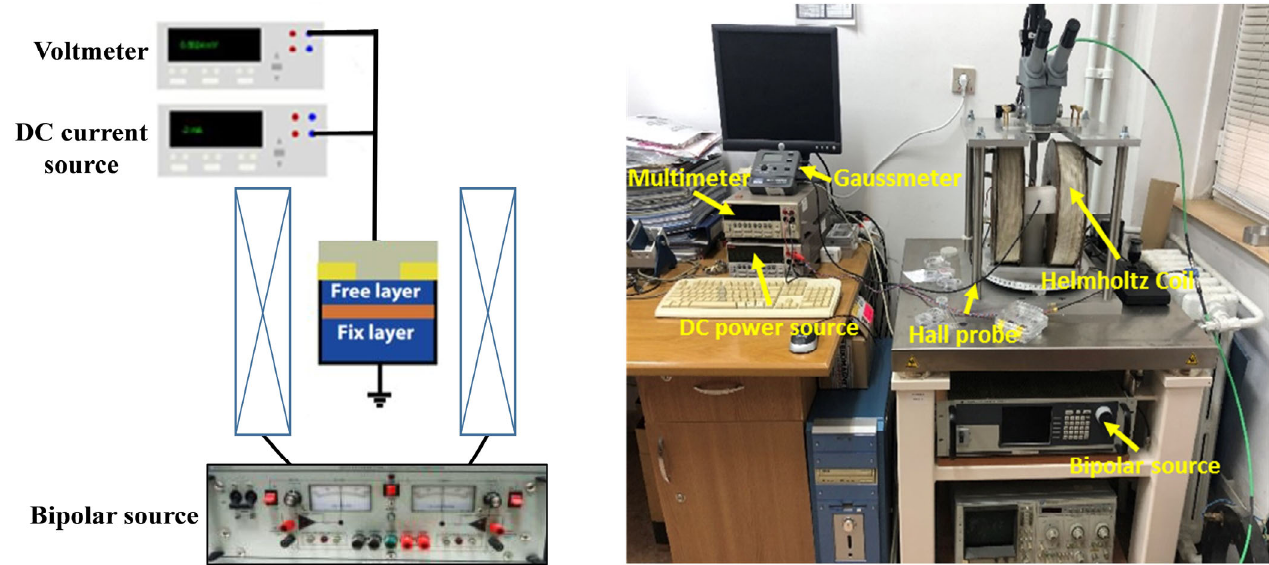
Figure 5. Schematic diagram and image of the experimental setup used for the TMR measurements.